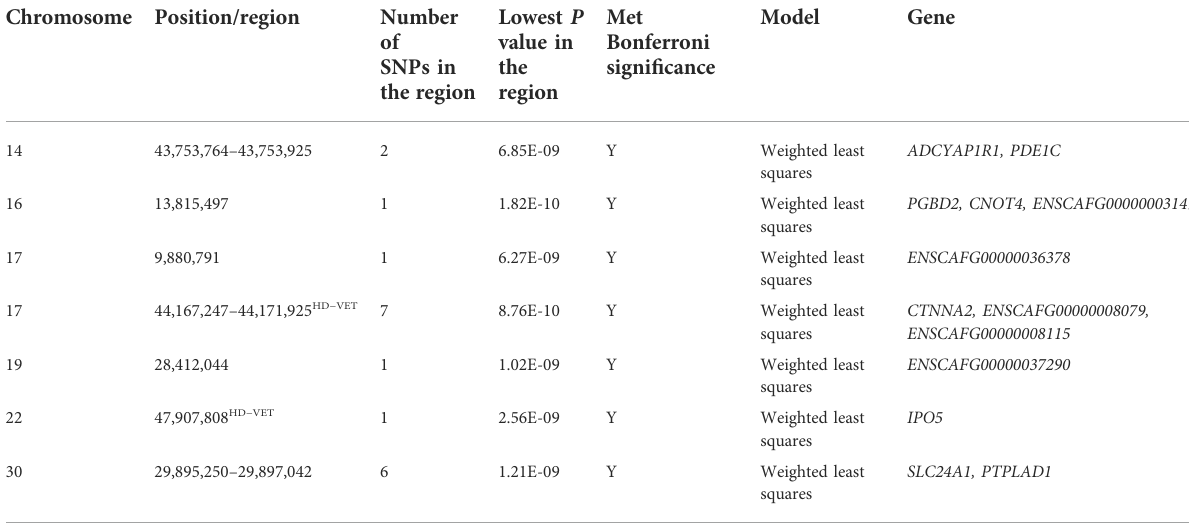
TABLE 6 ( Continued ) Top candidate loci associated with anterior cruciate ligament rupture in across-breed GWAS using breed phenotypes and four different association